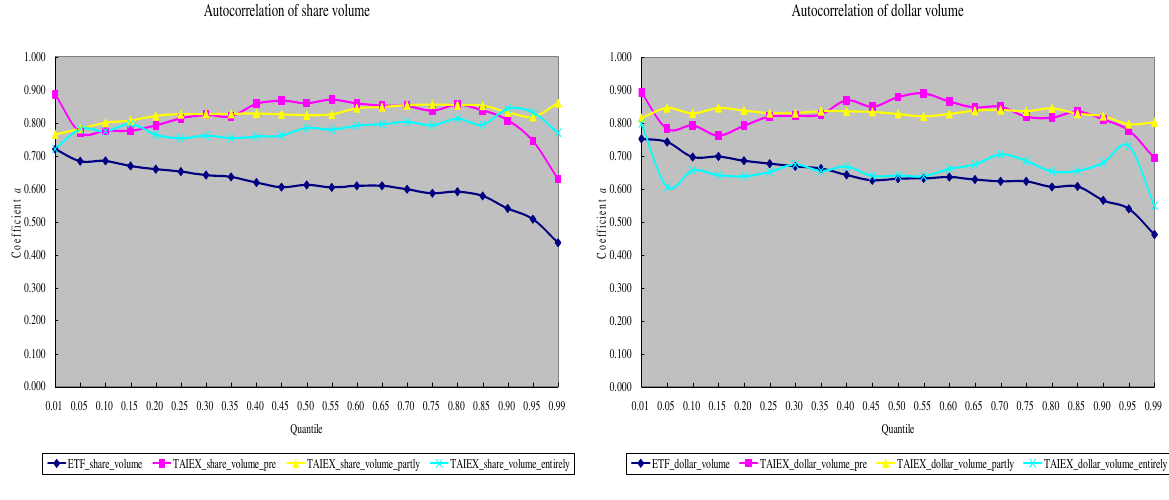
Fig. 3. Autocorrelations of volume series